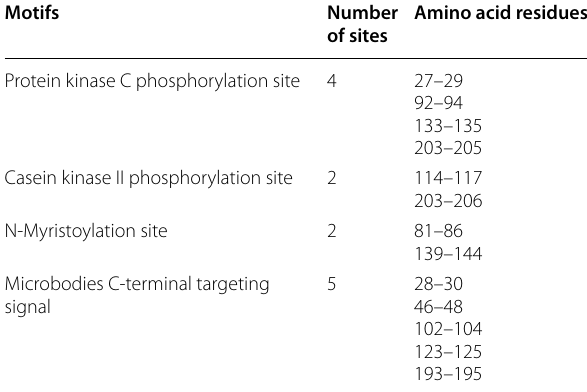
Table 5 Motif regions present in the Y-domain protein sequence Motifs